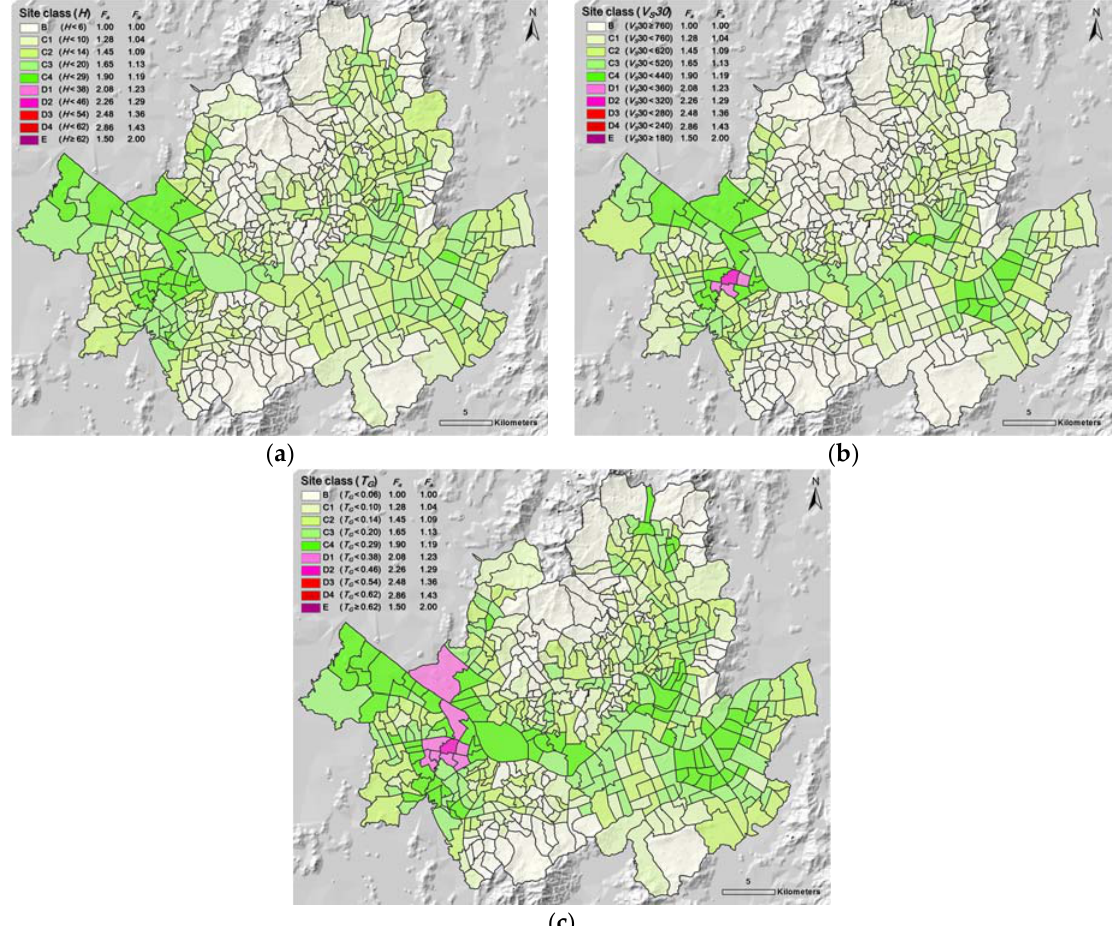
Figure 8. Site classes with administrative subunits based on the average grid values for three site effect parameters: ( a ) bedrock depth ( b ) V S 30 and ( c ) T G .